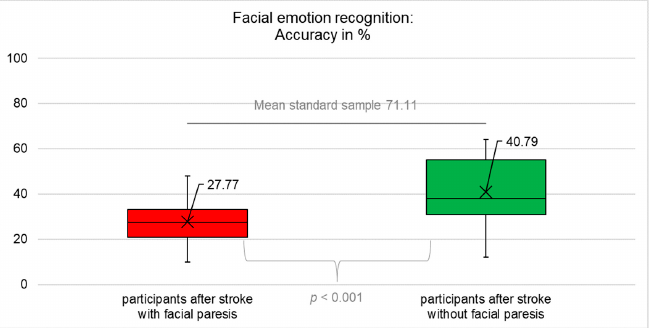
Figure 1. Accuracy of facial emotion recognition (mean, median, interquartile range). Participants after stroke with facial paresis performed significantly worse compared to healthy controls ( p < 0.001) and compared to participants after stroke without facial paresis ( p < 0.001). The data for healthy controls were not collected in this study but were taken from [46,47], so no information on the actual distribution of the data is available but only the mean as an indicator of the central tendency. Therefore, the figures only contain two box plots, not three.